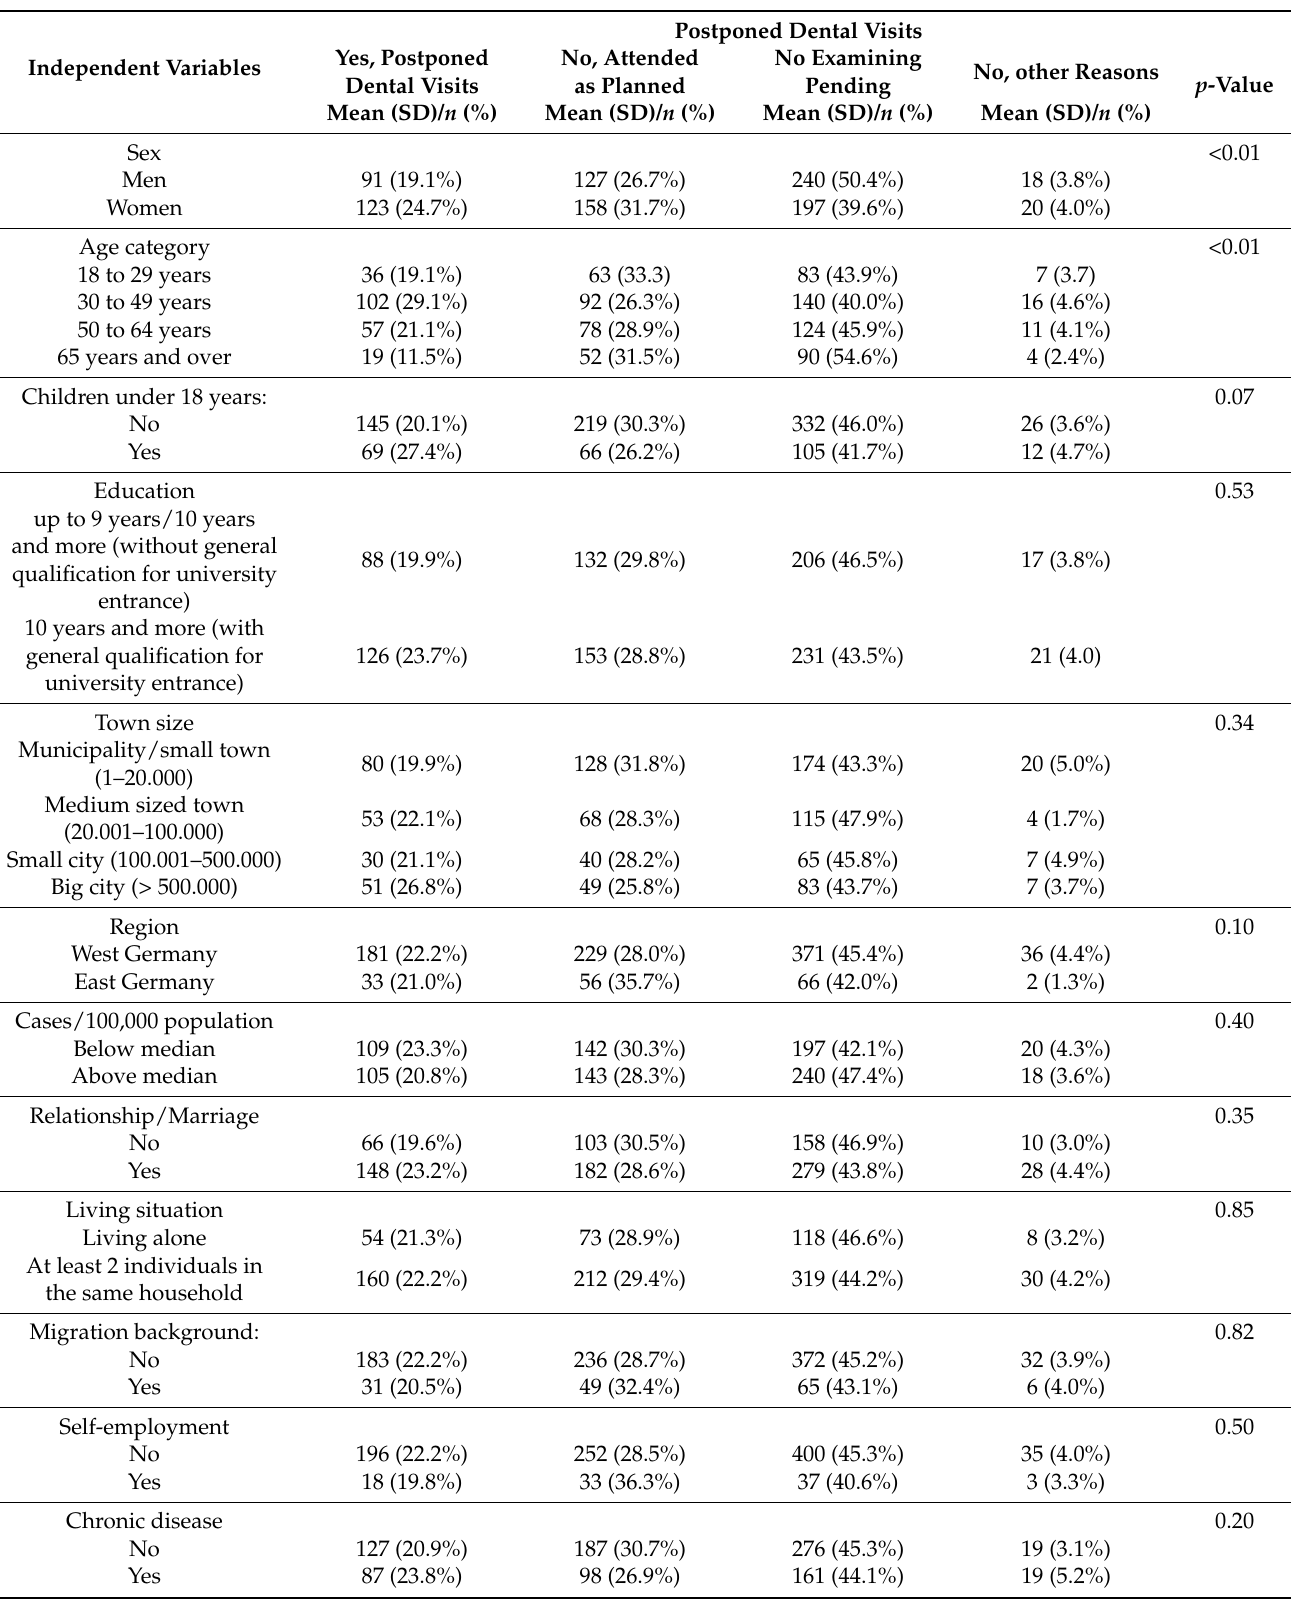
Table 1. Sample characteristics for the analytical sample ( n = 974 individuals) at wave